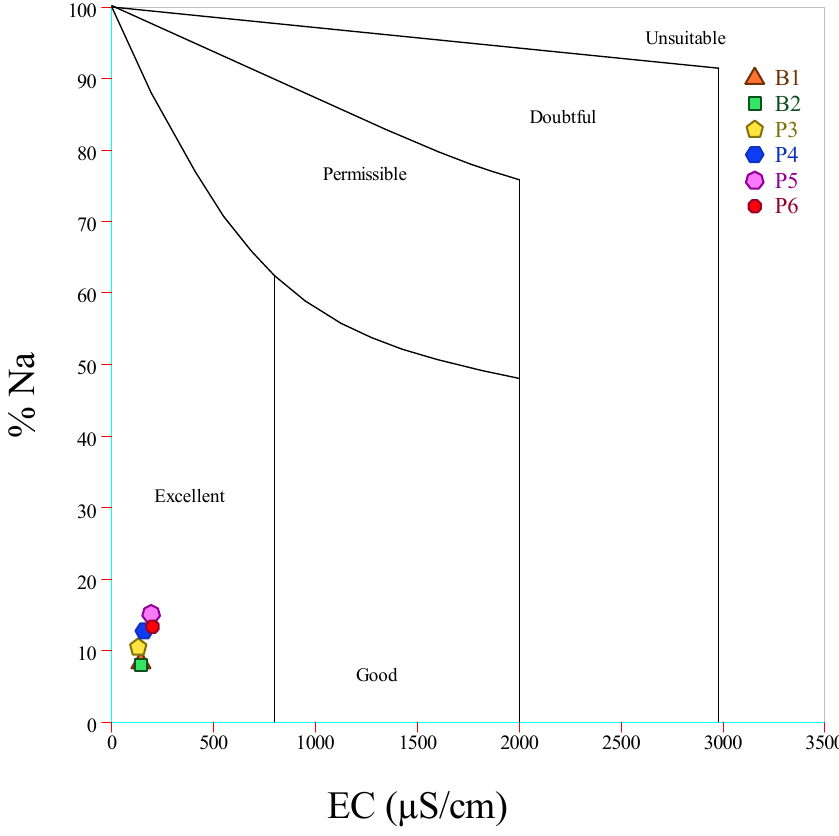
Figure 11. USSL diagram for assessing irrigation water quality.